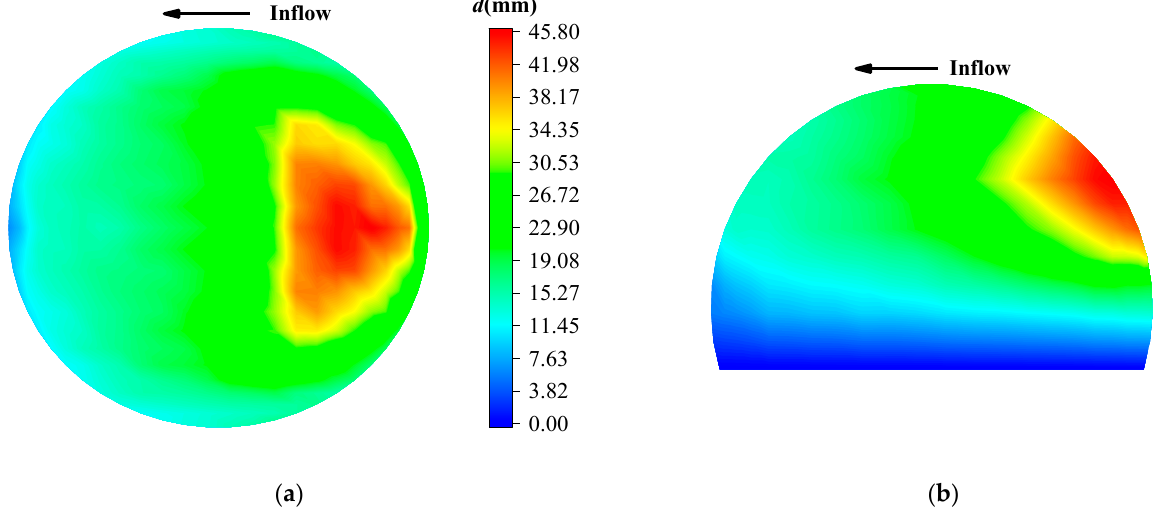
Figure 8. Contour of total displacement for the model: ( a ) top view and ( b ) side view.